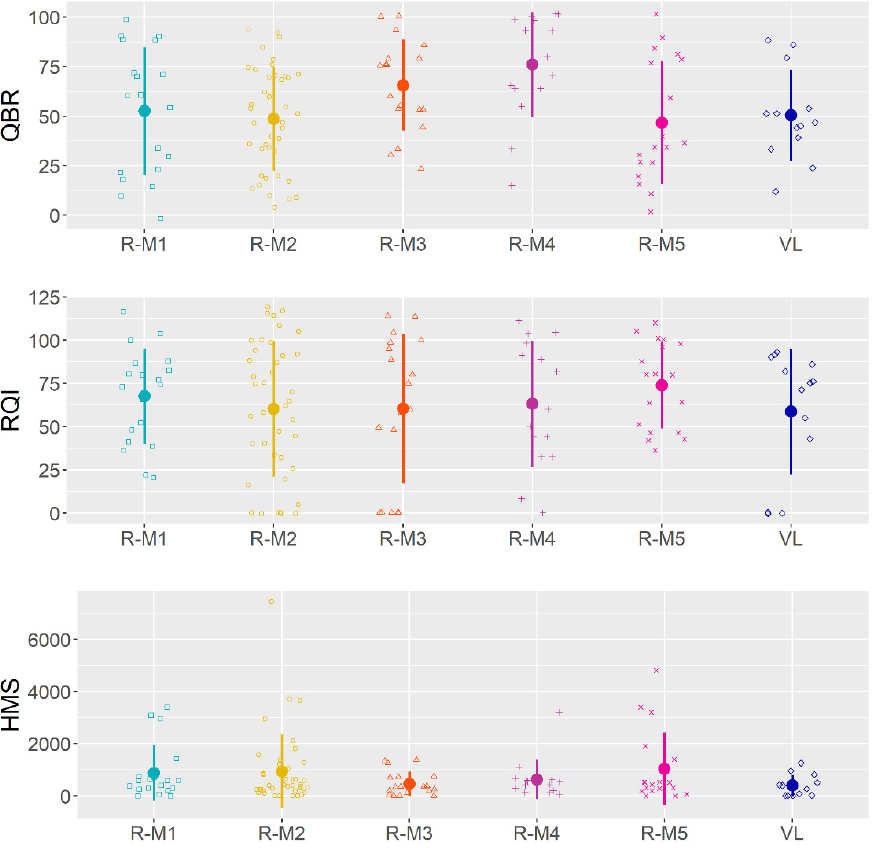
Figure 7. Strip charts (1D scatter plots) of QBR, RQI, and HMS per Mediterranean River Types. Mean values and standard deviations are also shown.